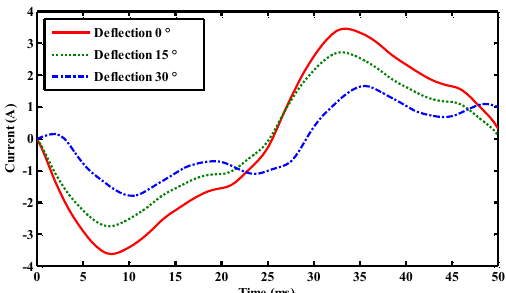
Figure 24. Current comparison diagram of phase A winding in three states. Energies 2020 , 13 , x FOR PEER REVIEW